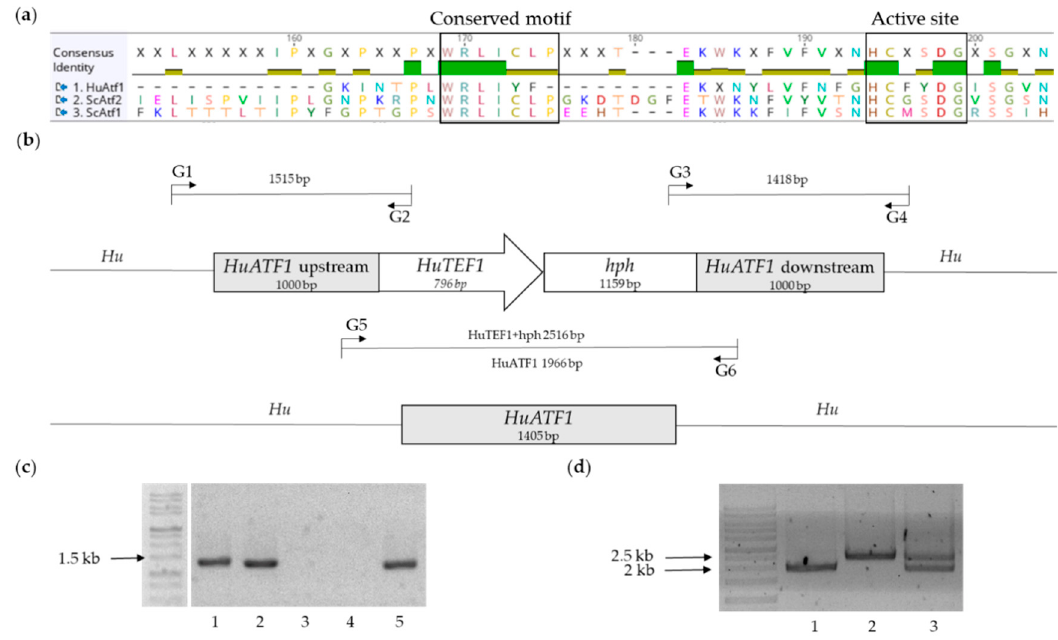
Figure 2. ( a ) Alignment of the amino acid sequence of the Hanseniaspora uvarum HuAtf1 with the two S . cerevisiae Atf proteins. The conserved WRLICLP motif as well as the HXXXDG active site [42] are shown in boxes; ( b ) Replacement of the HuATF1 ORF by HuTEF1_hph . HuATF1 was replaced by the HuTEF1 promoter in front of the selection marker hph with 1000 bp of flanking regions that are upstream and downstream of the HuATF1 ORF. The G1/G2, G3/G4, and G5/G6 diagnostic primer sets were used to verify correct integration of the marker cassette and deletion of HuATF1 . The G5/G6 primer set was used to determine the absence of HuATF1, and thus a double knock-out due to the different nucleotide size of HuATF1 and HuTEF1 - hph ; ( c ) GelRed stained agarose gel showing PCR amplification of HuATF1 using primer set 39/40. (1) DSM2768 Ctrl, (2) DSM2768 #34 (WT/ Δ ), (3) DSM2768 #40 ( Δ / Δ ), (4) DSM2768 #46 ( Δ / Δ ), (5) DSM2768 #97 (WT/ Δ ). Resulting bands with size of ~1.4 kb; ( d ) GelRed stained agarose gel showing PCR amplification of wild type, single, or double knock-out of HuATF1 using primer set 41/42 (G5/G6). (1) DSM2768 Ctrl, (2) DSM2768 #40 ( Δ / Δ ), (3) DSM2768 #34 (WT/ Δ ). Resulting bands with size of 2 kb and 2.5 kb.